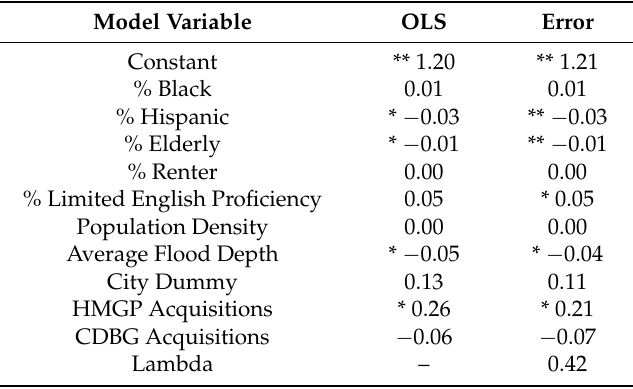
Table 7. Standardized coefficients for OLS and error